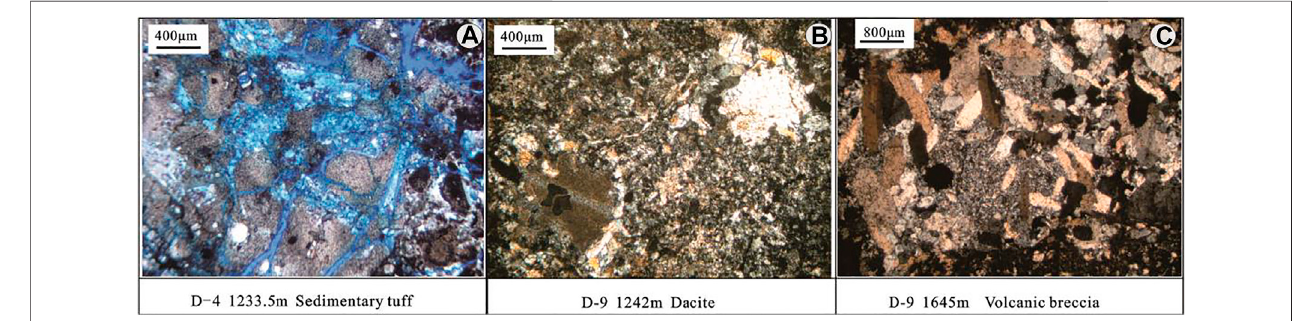
FIGURE 9 | Photos of fractures in the study